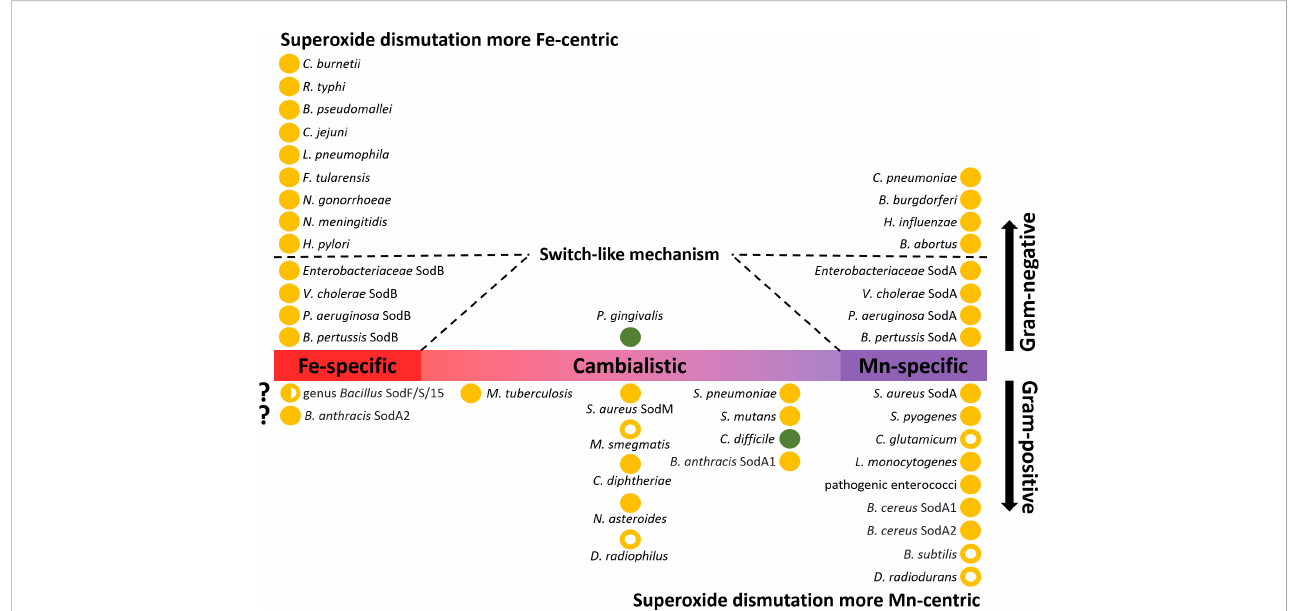
FIGURE 6 Distribution of Fe/Mn family superoxide dismutases (SODs) in Gram-negative and Gram-positive bacteria. SODs present in bacterial pathogens (closed circles) and selected non-pathogenic bacteria (open circles) are ranked according to their metal speci fi city (iron-speci fi c, manganese-speci fi c and cambialistic). If bacteria or groups of bacteria possess more than one SOD isoenzyme, these are indicated after the name of the species. Aerobic bacteria are depicted in orange, while strict anaerobes are depicted in green. Gram-negative bacteria that use a switch-like riboregulatory mechanism are depicted with dashed lines. In addition to the species mentioned in the text, the following bacterial species that code for SOD enzymes are shown in the fi gure: Neisseria gonorrhoeae and N. meningitidis (Archibald and Duong, 1986; Seib et al., 2004), Haemophilus in fl uenzae (Kroll et al., 1998), Porphyromonas gingivalis (Hiraoka et al., 2000), Coxiella burnetii (Heinzen et al., 1992), Rickettsia typhi (McLeod et al., 2004), Burkholderia pseudomallei (Loprasert et al., 2000), Campylobacter jejuni (Atack and Kelly, 2009), Legionella pneumophila (Sadosky et al., 1994), Francisella tularensis (Bakshi et al., 2006), Helicobacter pylori (Ernst et al., 2005), Chlamydia pneumoniae (Yu et al., 2004), Borrelia burgdorferi (Aguirre et al., 2013), Brucella abortus (Sriranganathan et al., 1991), Streptococcus pneumoniae , S. mutans , and S. pyogenes (Gerlach et al., 1998; De Vendittis et al., 2010; Eijkelkamp et al., 2014), Mycobacterium tuberculosis and M. smegmatis (Yamakura et al., 1995; Bunting et al., 1998; Padilla-Benavides et al., 2013), Corynebacterium diphtheriae (Britton et al., 1978), and C. glutamicum (El Shafey et al., 2008), Listeria monocytogenes (Britton et al., 1978) Enterococcus faecalis (Verneuil et al., 2006; Wasselin et al., 2021), Nocardia asteroides (Beaman et al., 1983), and Deinococcus radiophilus (Yun and Lee,